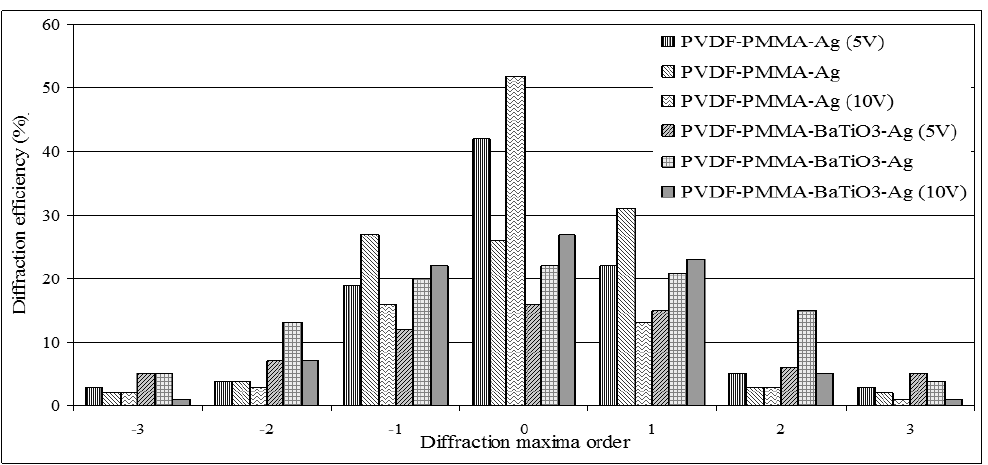
Figure 6. Diffraction efficiencies before and after applied bias to novel